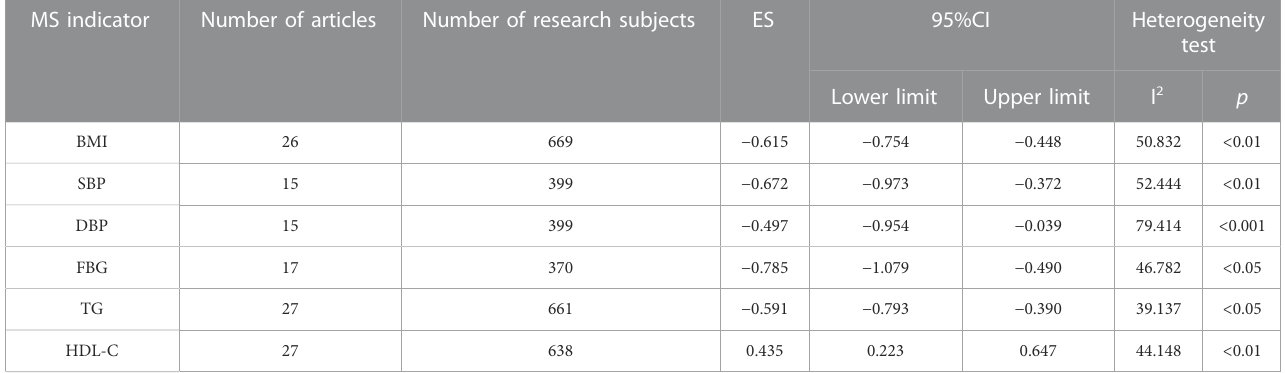
TABLE 2 Main effects of the indicators of metabolic syndrome.